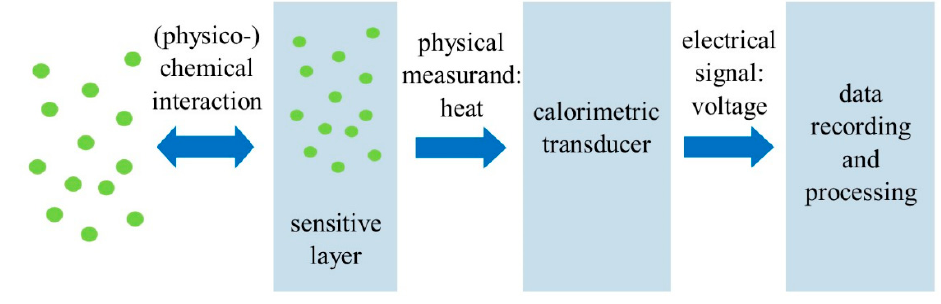
Figure 2. Calorimetric gas sensor principle.